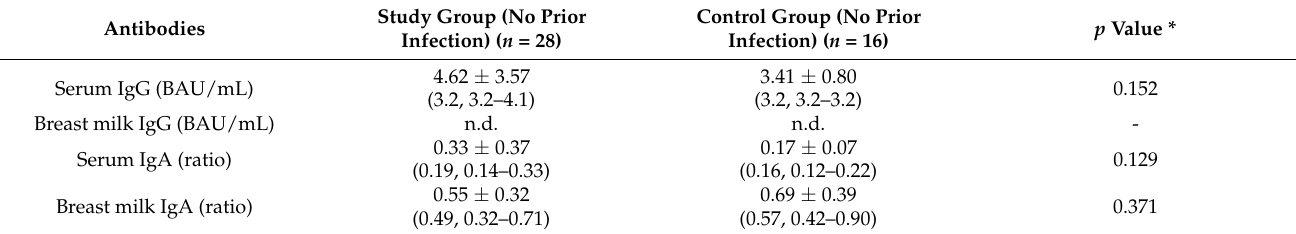
Table 2. Baseline serum and breast milk IgG and IgA antibodies in study and control groups.